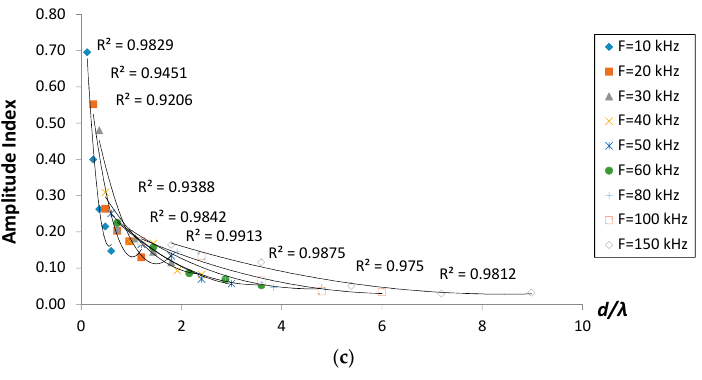
Figure 6. Amplitude index versus d/ λ for crack cases ( a ) 30° inclined; ( b ) vertical (90°) and ( c ) 150° inclined.